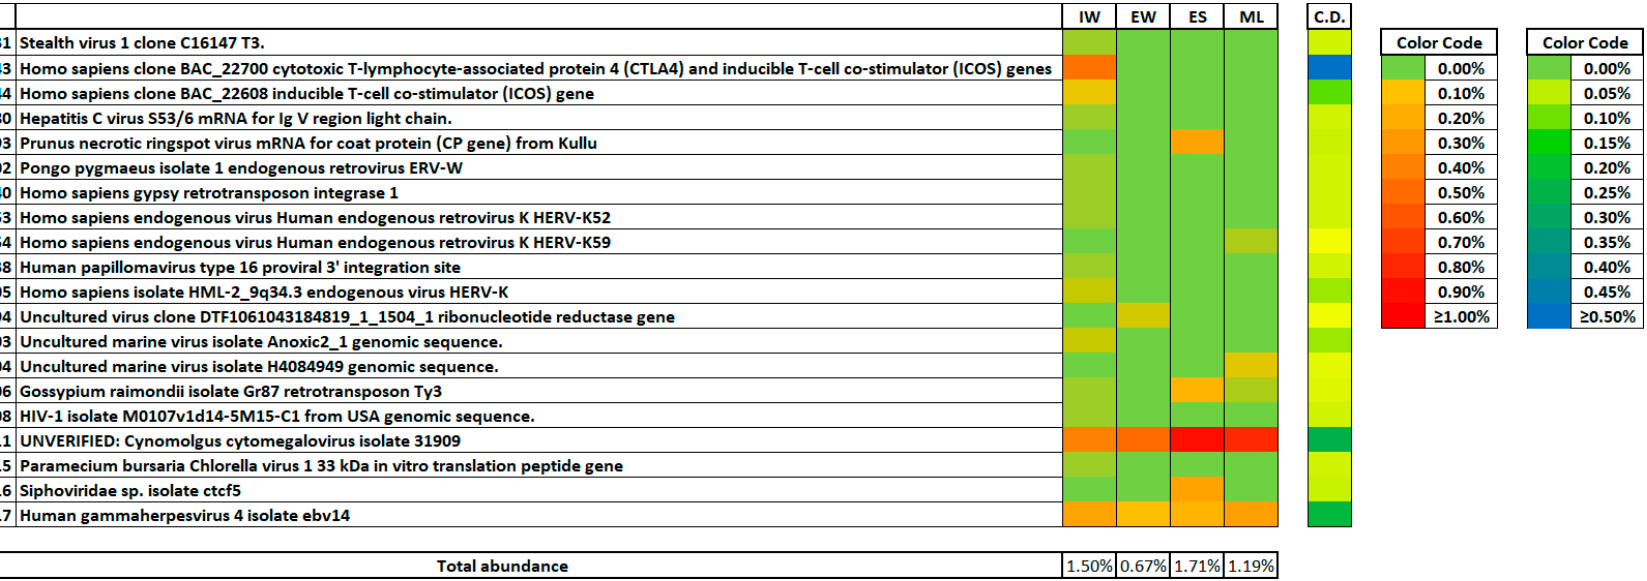
Figure 3. Dominant viral phylotypes that infect eukaryotic cells found in different sampling locations in an at full-scale. IW: influent wastewater; EW: effluent water; ES: excess sludge; and ML: mixed liquor from the aerobic bioreactor, C.D.: contribution to dissimilarity as per SIMPER.